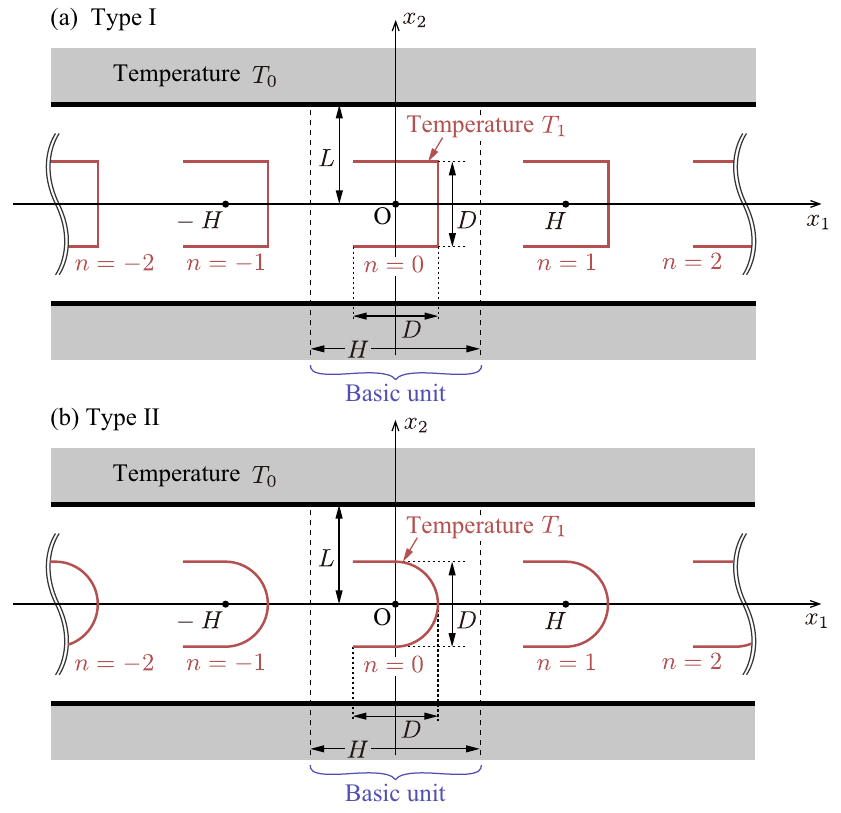
Figure 2. Schematics of the problem: ( a ) type I and ( b ) type II. In panel ( a ) [or ( b )], infinitely many square-U (or round-U) bodies are arranged periodically along the x 1 -axis with period H between two parallel plates. The D D 0 , 1 , 2 , . . . ), are uniformly heated at a constant x 1 nH n U-shaped bodies, located at nH 2 ≤ 2 ( ≤ + − = ± ± temperature T 1 , while the plates are kept at a uniform temperature T 0 ( T 1 > T 0 ). In both type I and type II, the H < x 1 < H L < x 2 < L forms a basic part 2 2 and − −